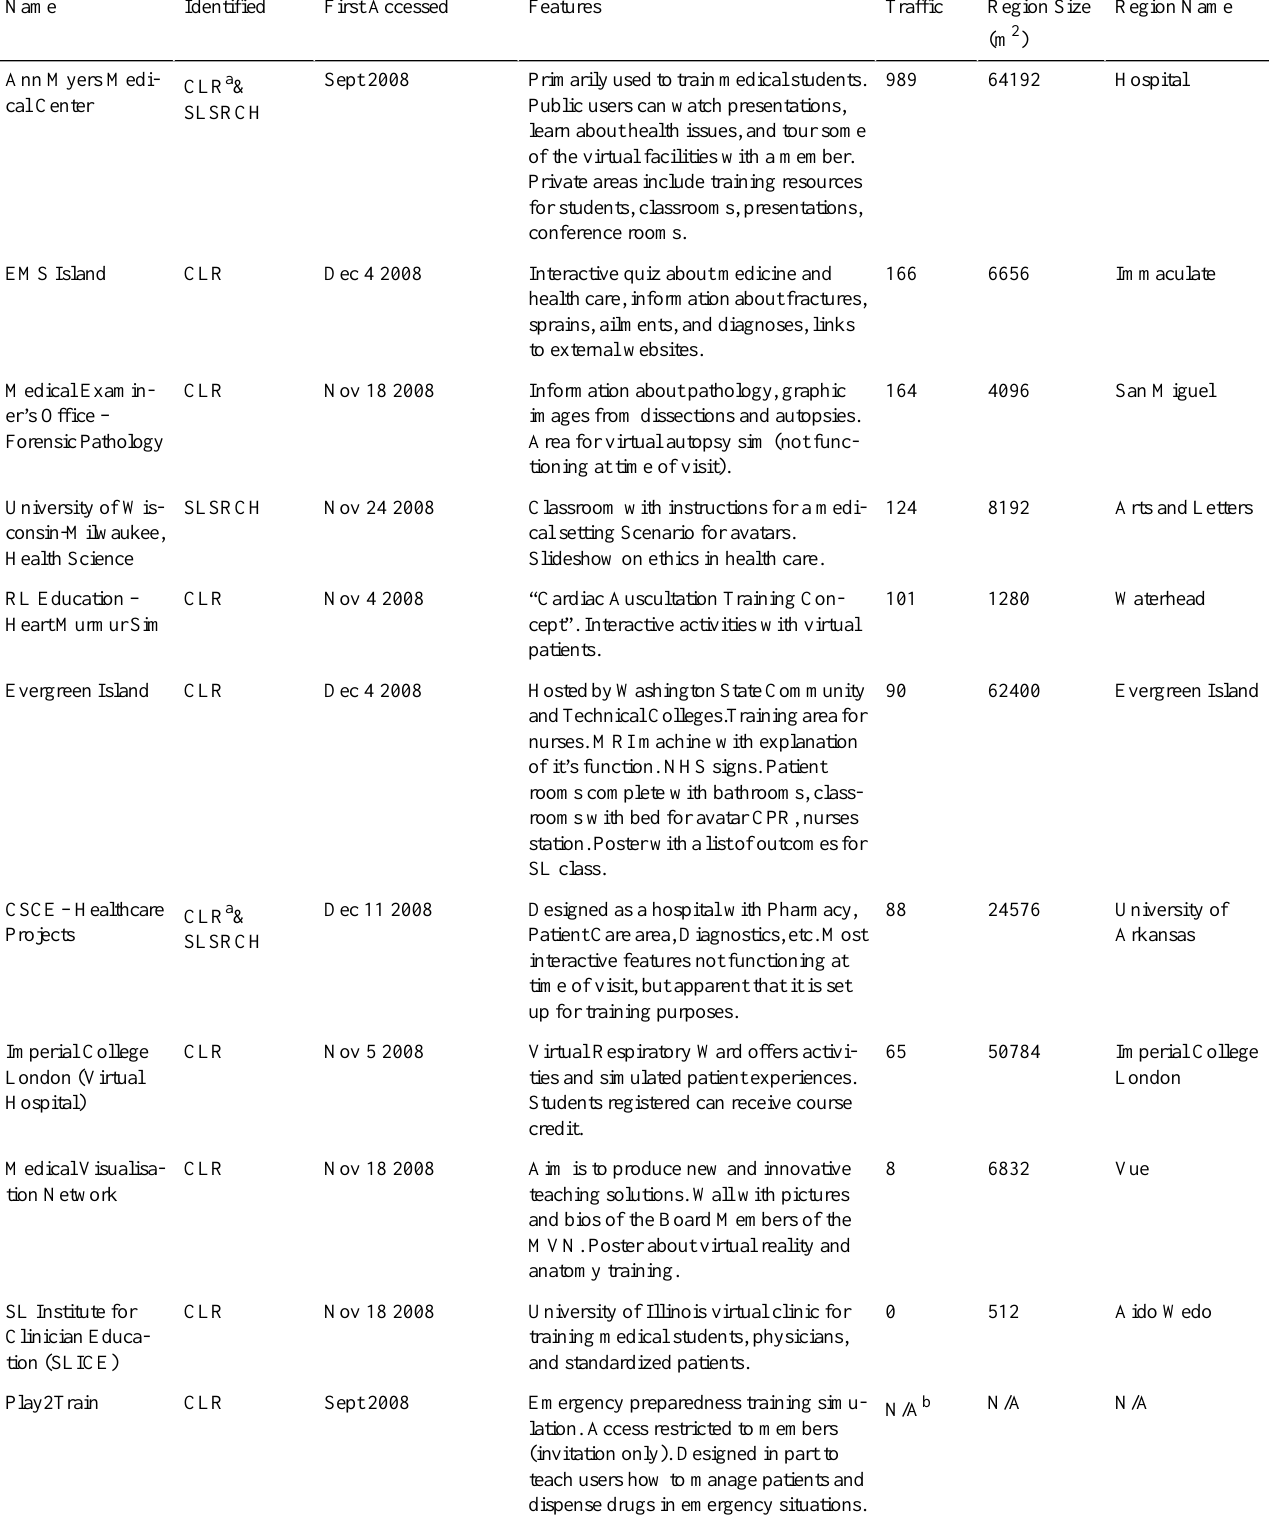
Table 4. Training sites (ranked by